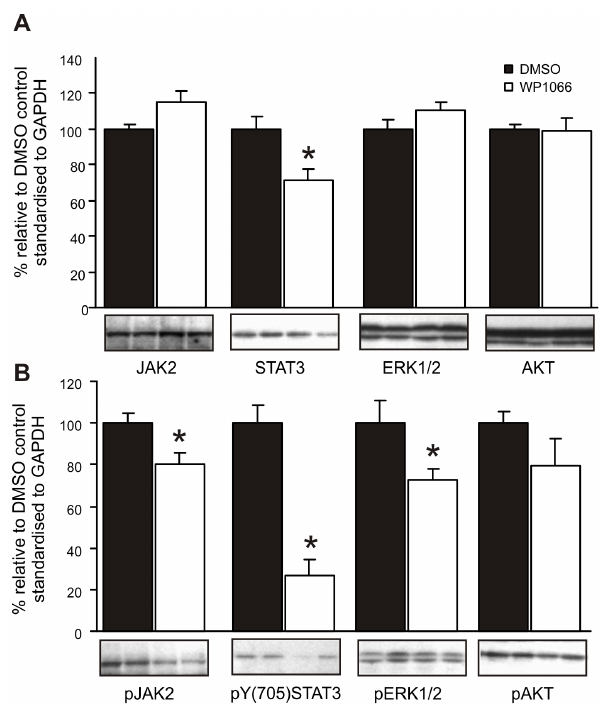
Figure 4. WP1066 inhibits STAT3 signalling. gp130 757FF mice (8 weeks old) were treated as in Fig. 3 and antral extracts quantified by Western blotting for total JAK2, STAT3, ERK1/2 and AKT (A) and pJAK2, pSTAT3, pERK1/2 and pAKT (B). Membranes were concurrently hybridised with a GAPDH antibody as a loading control. The intensity of the signal was quantified by densitometry and expressed as a percentage of the signal relative to the controls standardised to the intensity of the GAPDH signal. n=6–10; *significantly (p , 0.05).